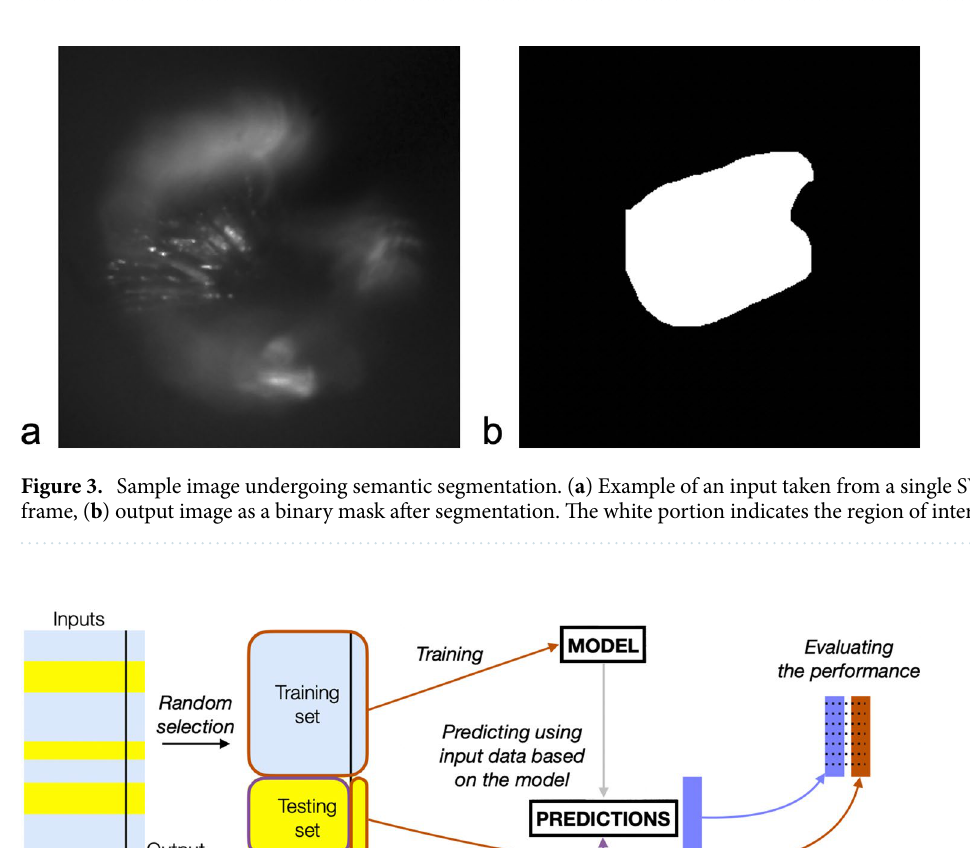
Figure 2. Examples of manual image review, where each frame of the shortwave infrared otoscopy video was annotated to label artifacts such as cerumen, hair, and non-focused regions. ( a ) Portion of tympanic membrane is non-focused, bounded between the red and yellow lines, ( b ) another example of annotations performed to exclude non-focused regions of the tympanic membrane.